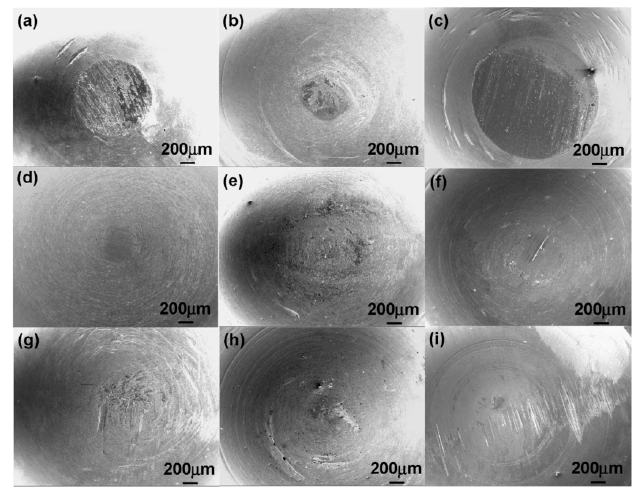
Figure 8. Wear morphology of two differently-processed Ti-29Nb-13Ta-4.6Zr (TNZT) alloys ( a ) TNZT1 and ( b ) TNZT3 and ( c ) a Ti-6Al-4V alloy (TAV1) sliding on a stainless steel plate; ( d ) TNZT1, ( e ) TNZT3, and ( f ) TAV1 sliding on ultra-high-molecular-weight polyethylene (UHMWPE); ( g ) TNZT1, ( h ) TNZT3, and ( i ) TAV1 sliding on a pig bone in 0.9% NaCl. Reproduced with permission from [81].